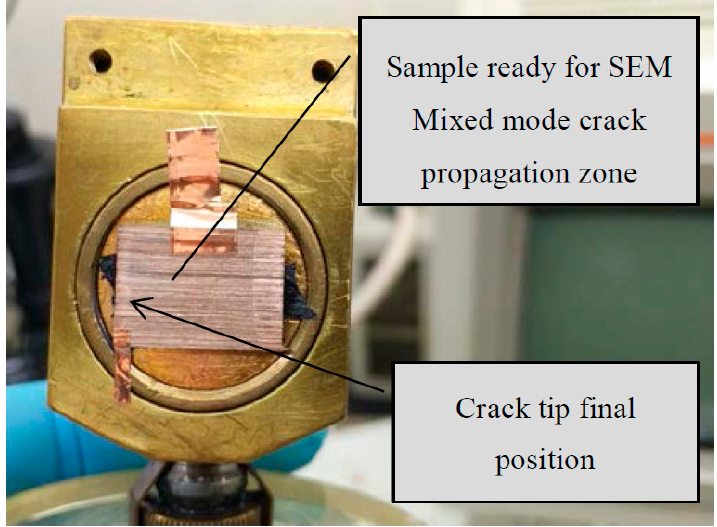
Figure 12. Sample prepared for scanning electron microscope.